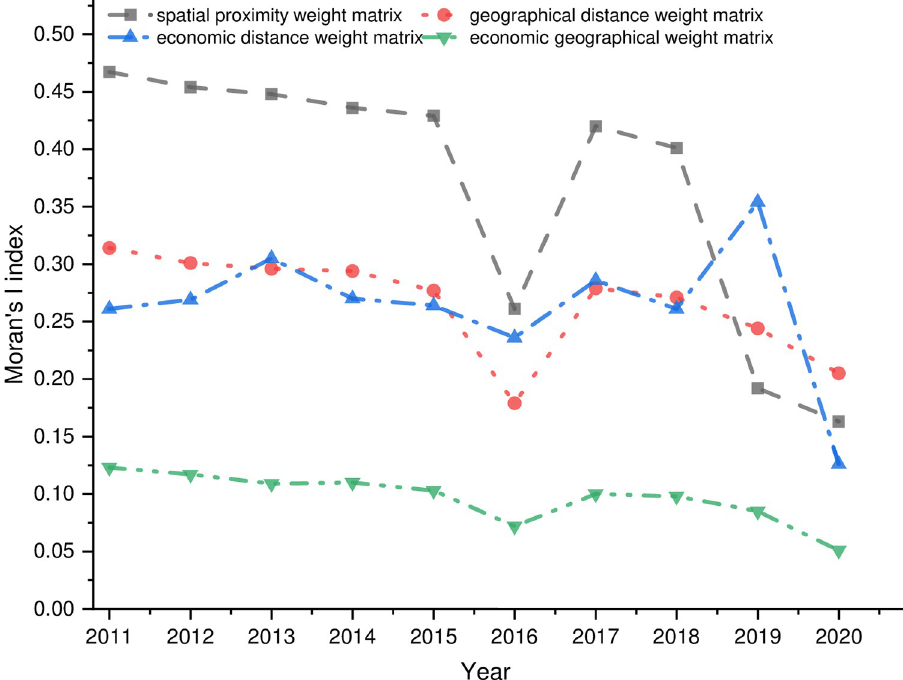
Fig 9. Moran test for different spatial weight